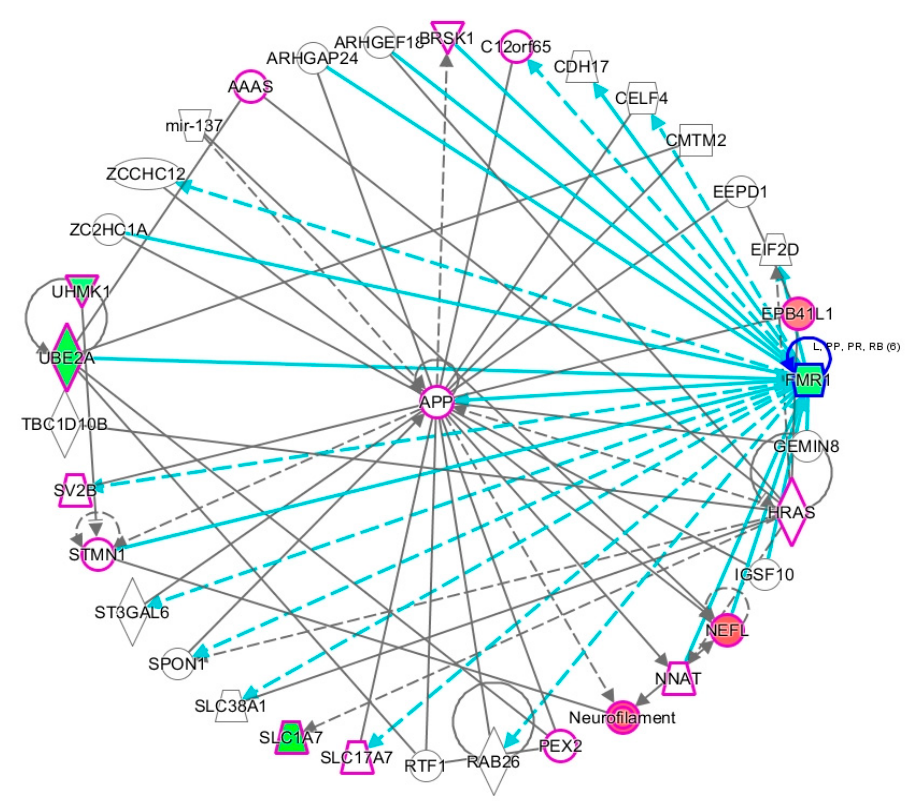
Figure 5. Gene network associated with DAGs enriched for ASD or intellectual disability. All genes involved in developmental disorder are outlined in purple. Genes colored red are hypermethylated while those colored green are hypomethylated. The turquoise colored lines indicate relationships between FMR1 and other genes in the network. Solid lines denote direct interactions; dashed lines denote indirect interactions.